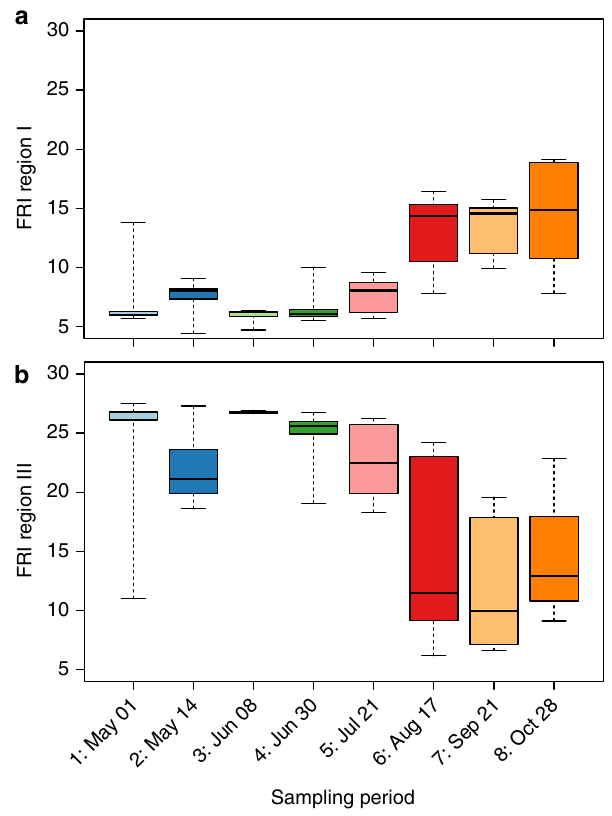
Fig. 2 Boxplots represent seasonal distributions of excitation-emission matrix spectra (EEMS) regions. EEMS region I: simple aromatic proteins ( a ), and EEMS region III: fulvic-type acids ( b ) across sampling period ( n = 49) within the complex river network. Regions II and IV (simple aromatic proteins and soluble microbial byproducts) follow similar seasonal patterns as region I, while region III and V (humic-type acids) are related. Each box spans the interquartile range; whiskers extend to the minimum